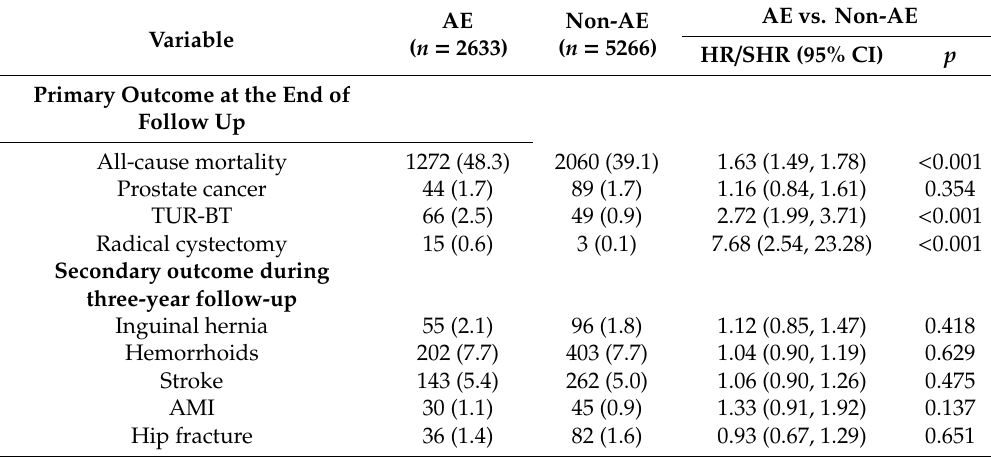
Table 4. Treatment outcomes during follow-up of patients with BPH who received alpha blocker